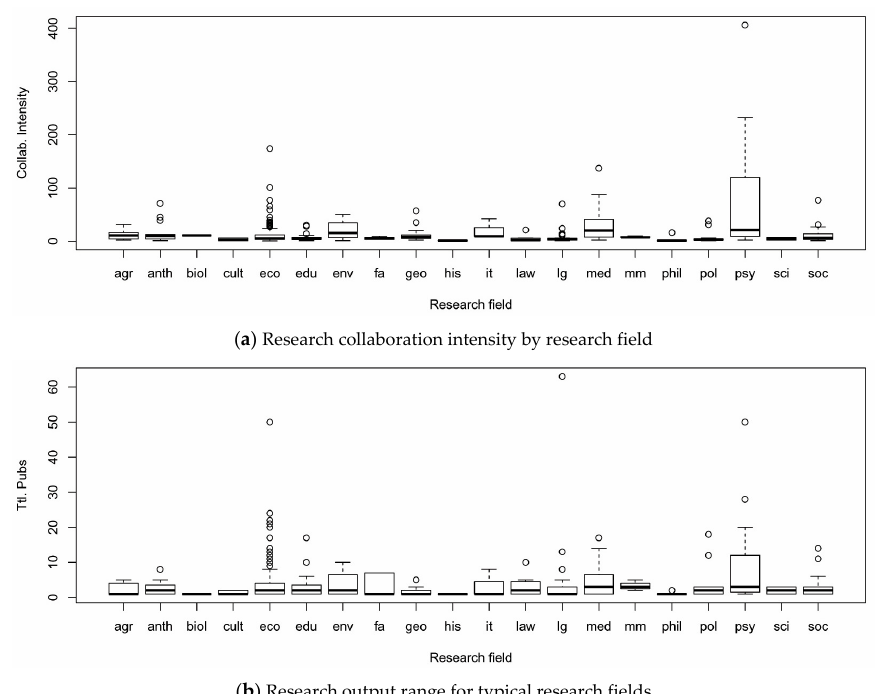
Figure 2. Distribution of the number of times an author collaborated with other authors and scientific output against research fields.